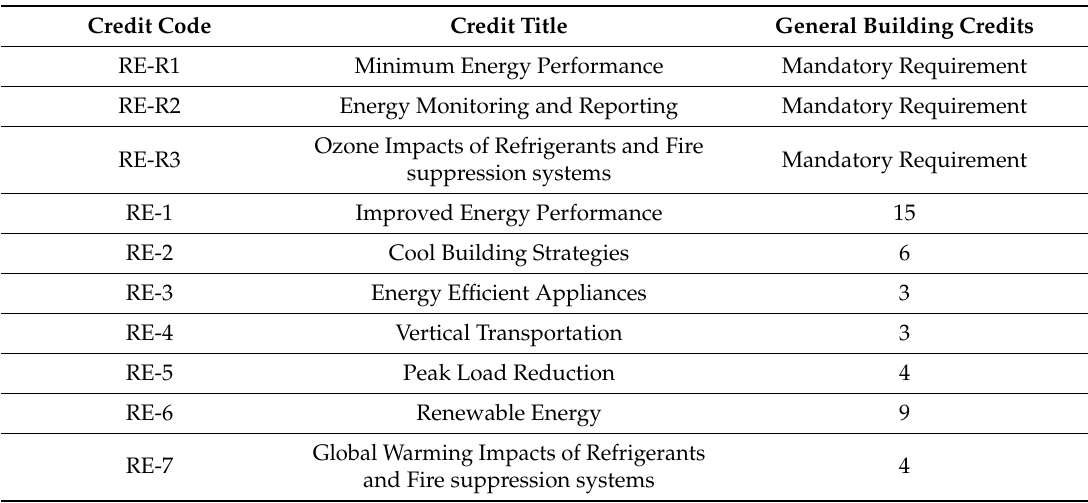
Table 1. Di ff erent credit categories under the “Resourceful Energy” (RE) category of the Pearl Rating